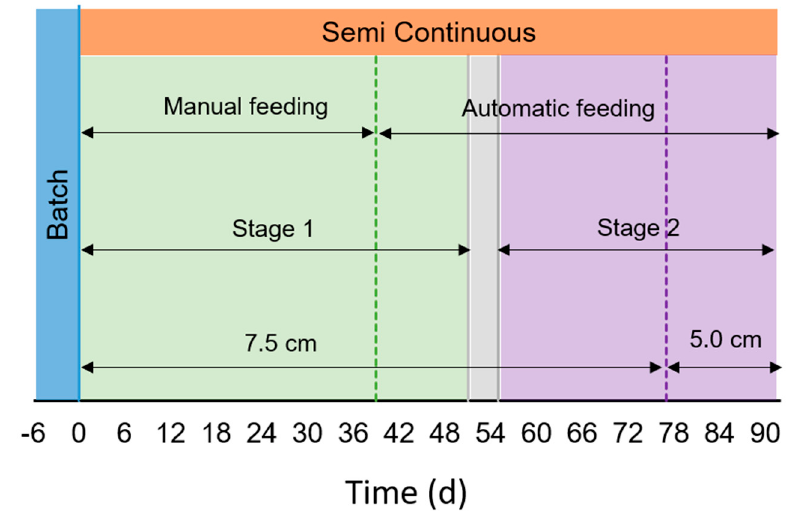
Figure 2. Scheme of operational design. Batch operation is represented in blue, , Semi-continuous operation in orange, , and the transition stage in grey, . Green represents the period of feeding with membrane filtered digestate (MFD), while violet with filtered digestate (FD). Green dotted line (....) represents the change in the feeding mode (from manual to automatic). Violet dotted line (....) represents the shift in the water depth.